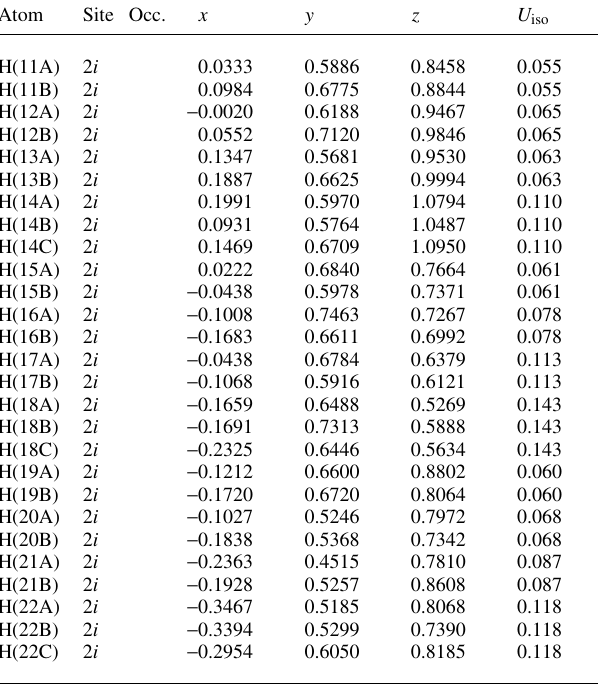
Table 2. Atomic coordinates and displacement parameters (in Å 2 ) .